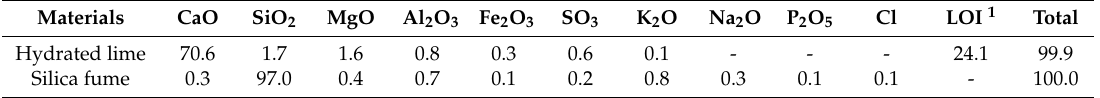
Table 1. Chemical composition of hydrated lime and silica fume.